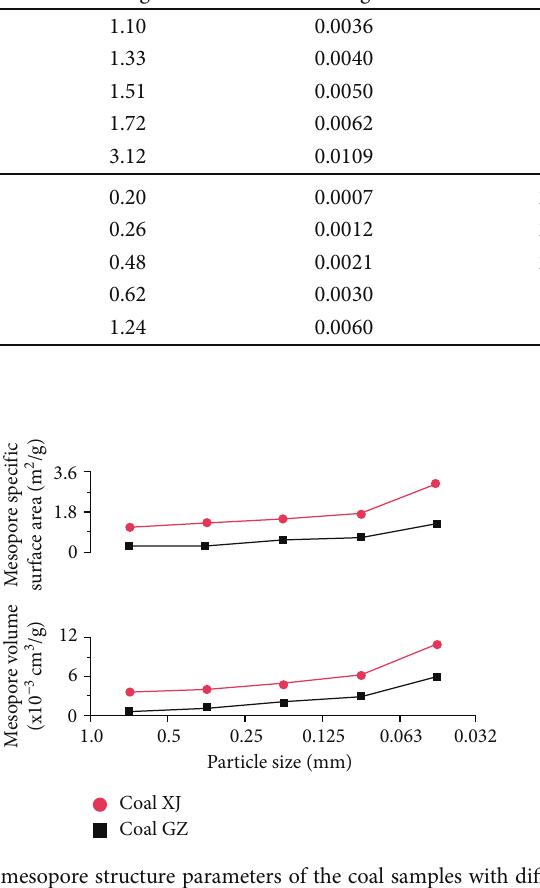
Table 2: Pore structure parameters using low-pressure gas adsorption analysis on the coal subsamples with di ff erent particle sizes. Subsample no.